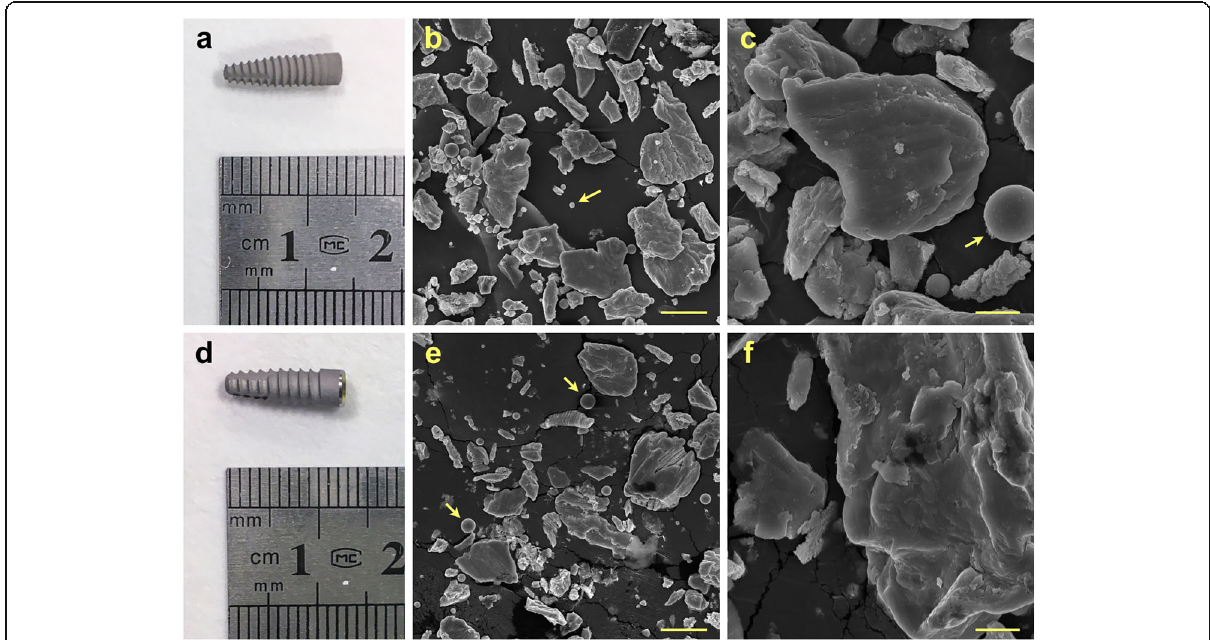
Fig. 1 Representative photo of implants and SEM images of particles produced by mock implantoplasty procedure. a – c Straumann 021.4512, bone level, diameter 4.1 mm, regular CrossFit®, SLA® 12 mm Roxolid® (commercially pure grade 4 titanium). d – f Biohorizons PBR 50105, RBT 5.0 × 10.5 mm, 5.7 Platform (grade 5 titanium alloy). Arrows indicate titanium oxide spheres. Scale bar represents 20 and 5 μ m for low and